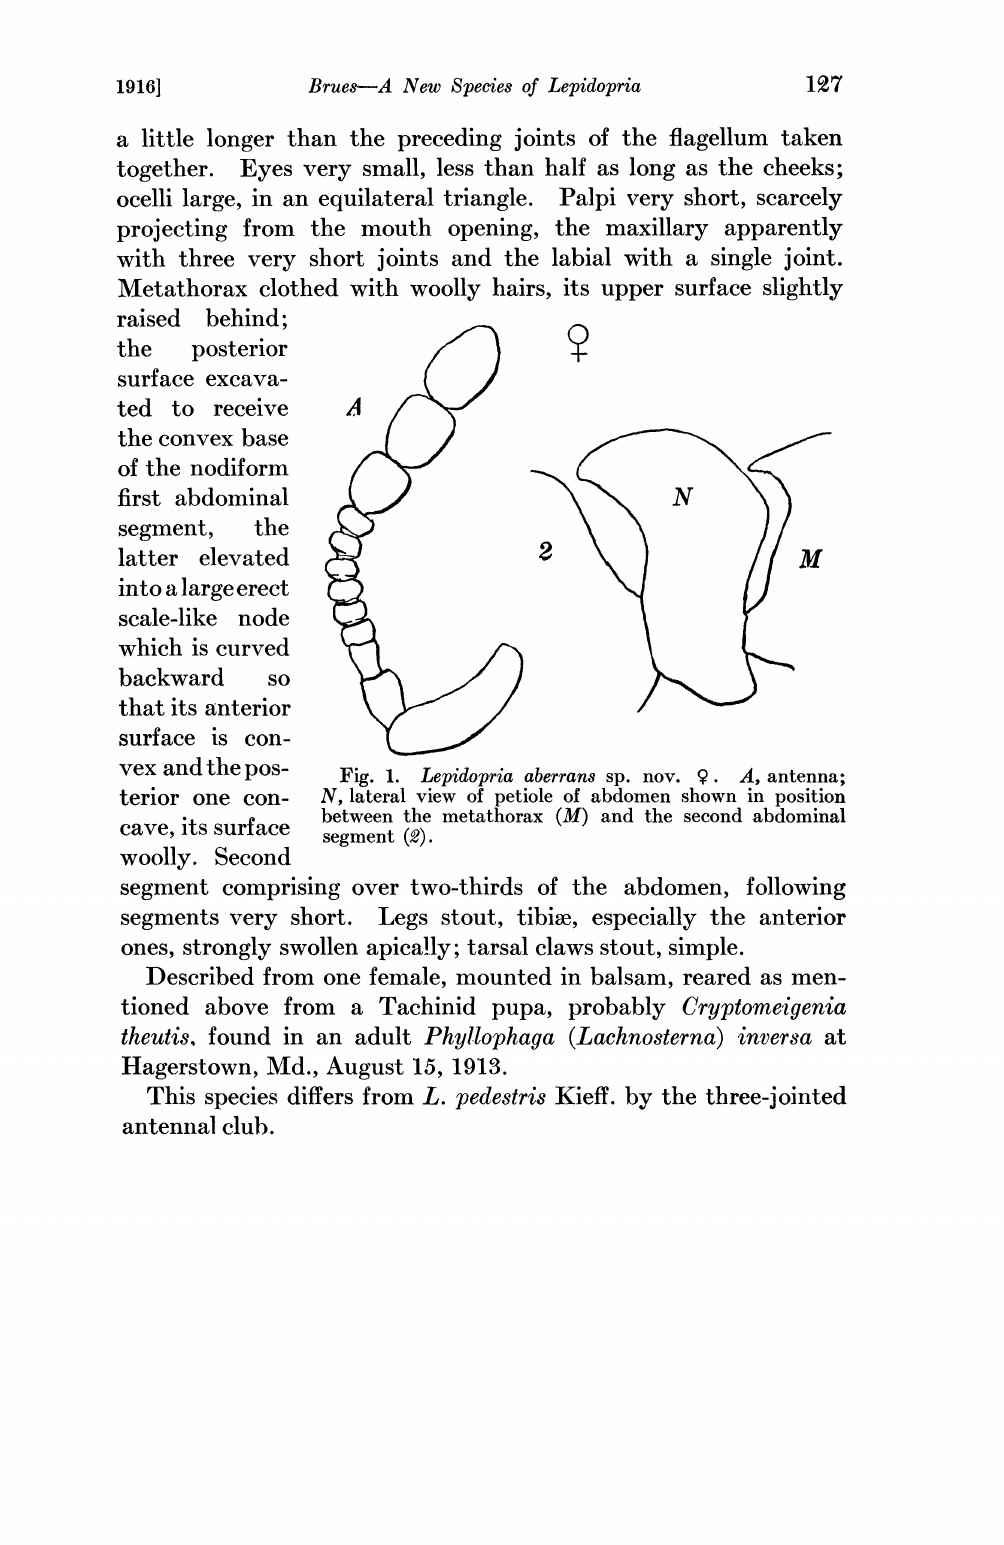
Fig. 1. Lepidopria aberrans sp. nov. Q. A, antenna; terior one con- N, lateral view of petiole of abdomen shown in position between the metathorax (M) and the second abdominal cave, its surface segment (2). woolly.